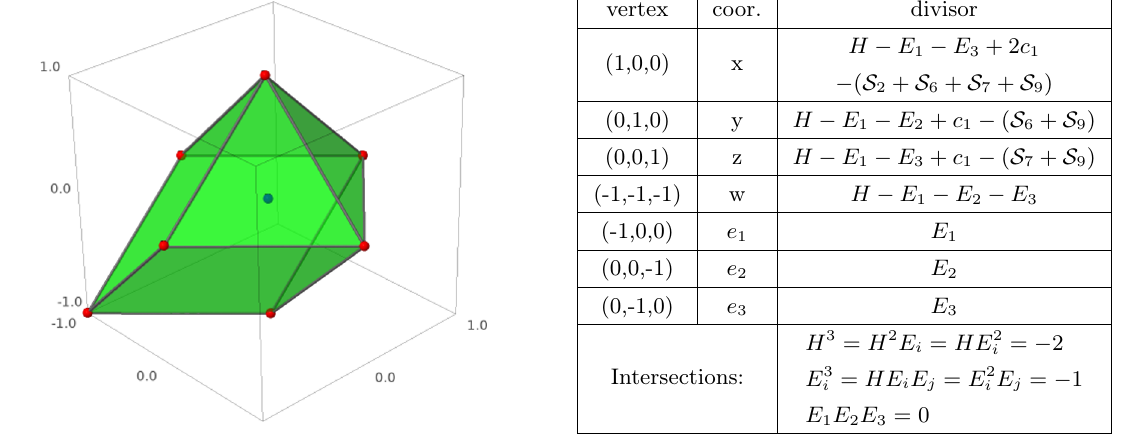
Figure 6 . The polytope and data associated to the ambient space Bl 3 P 3 of nef (67,0). The latter generically leads to a rank three Mordell-Weil